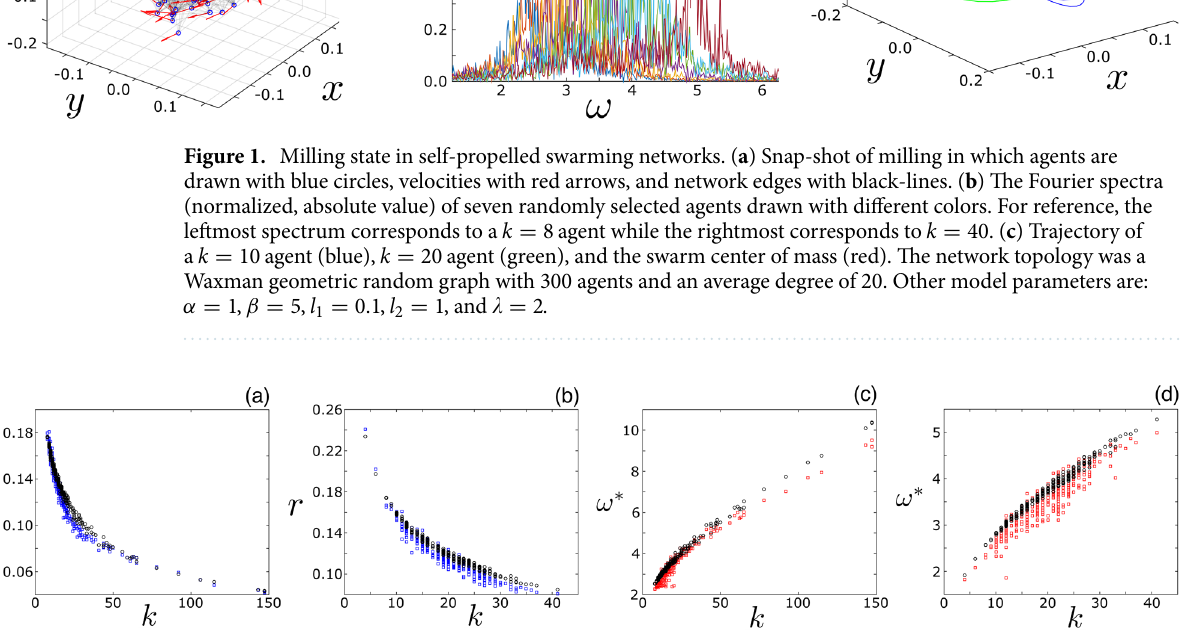
Figure 2. Averaged milling state oscillations. The average distance to the swarm’s center of mass versus the agent degree for a power-law network ( a ) and a Waxman geometric random graph ( b ). Simulation results are shown with blue squares and mean-field predictions with black circles from solving Eqs. (3a–3b). Peak frequency from the Fourier spectra versus agent degree for the same power-law network ( c ) and Waxman geometric random graph ( d ). Simulation results are shown with red squares and mean-field predictions with black circles. Each network was composed of 300 agents with an average degree of 20. Other model parameters are identical to Fig.